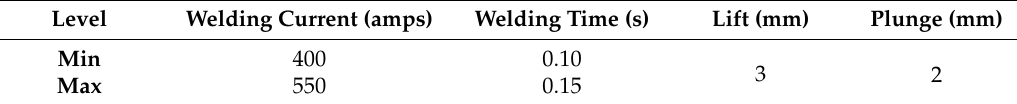
Table 3. Maximum and minimum values of welding parameters utilized in this